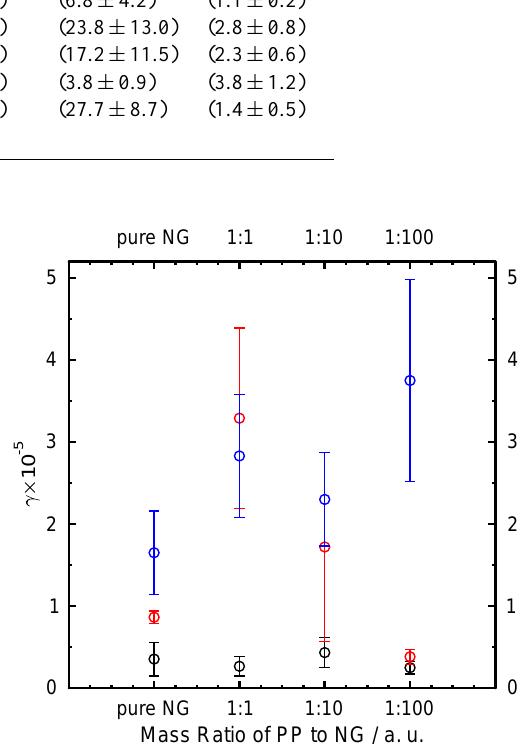
Fig. 6. Steady-state reactive uptake coefficients, γ , as a function of mass ratio of Pahokee peat to 5-nitroguaiacol. Black, red, and blue open circles denote dark, VIS, and UV irradiated uptake experi- ments, respectively. Errors bars denote 1 σ of the mean γ